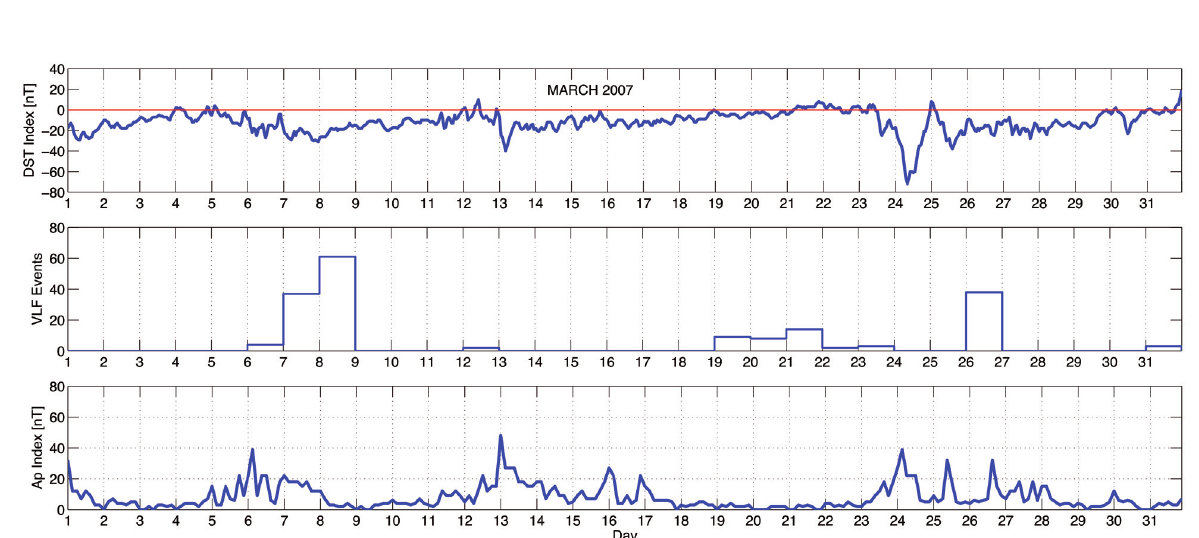
Figure 2 (continues on following page). Time profile of the disturbance events on the VLF amplitude signal, and the Dst and Ap magnetic indices for January to June 2007, as